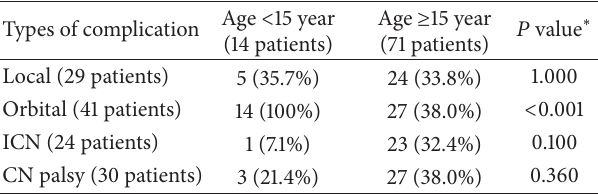
Table 2: Types of complication classified by age